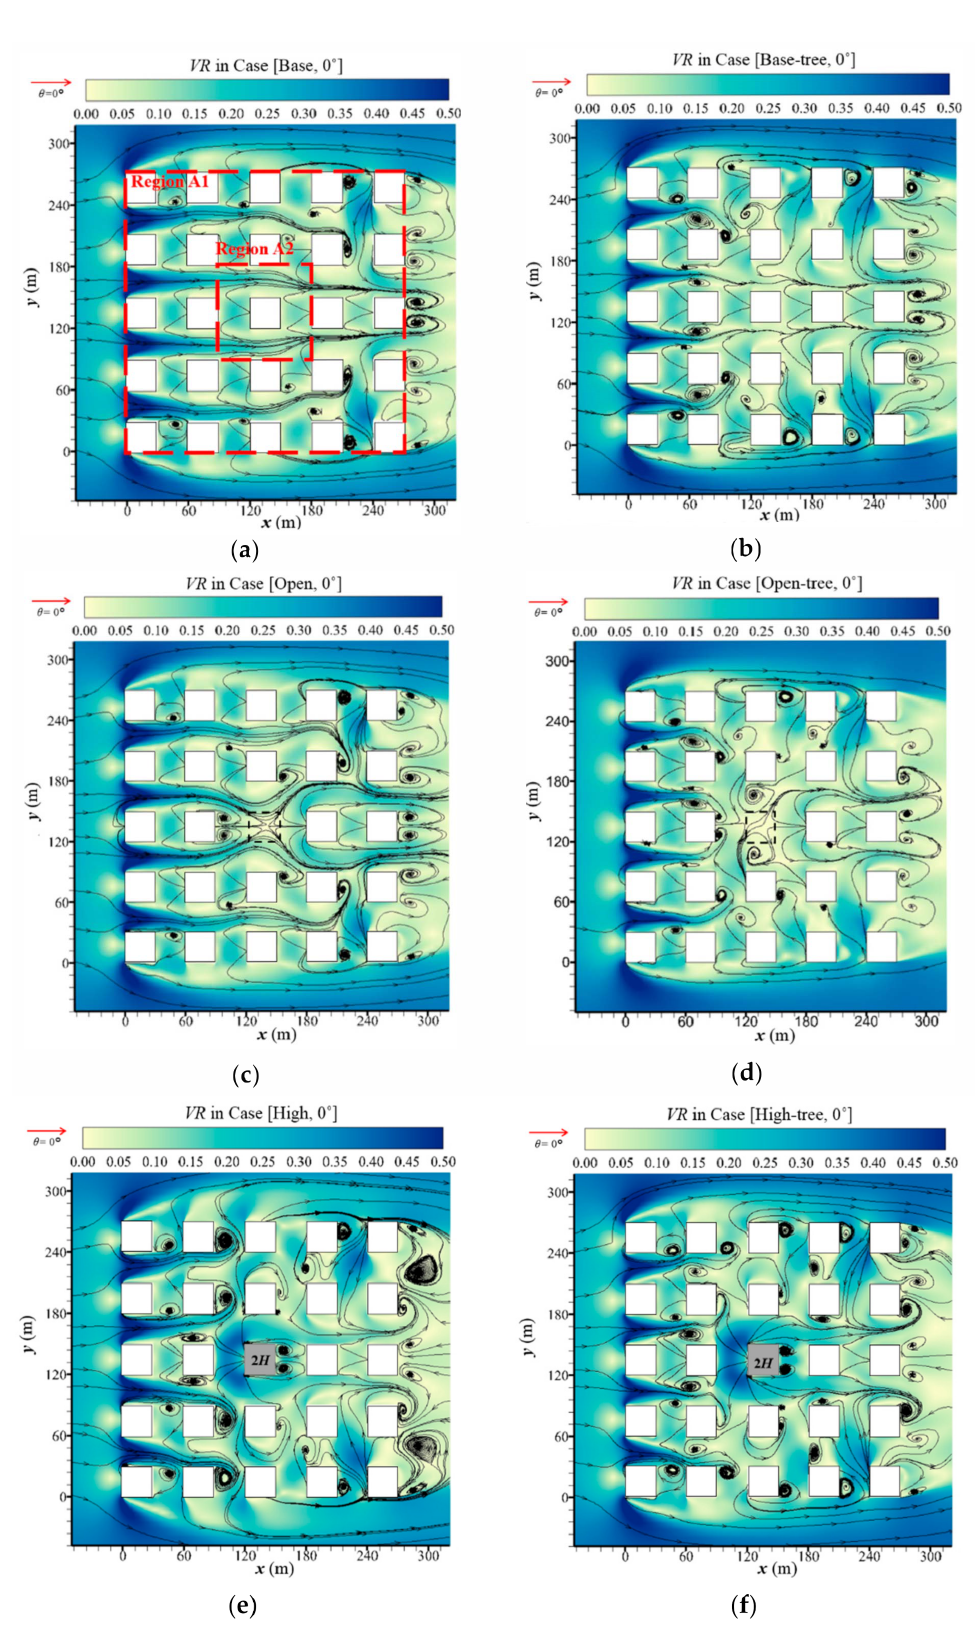
Figure 2. Streamline and velocity ratio ( VR ) at z = 2m in ( a ) Case [Base, 0 ◦ ], ( b ) Case [Base-tree, 0 ◦ ], ( c ) Case [Open, 0 ◦ ], ( d ) Case [Open-tree, 0 ◦ ], ( e ) Case [High, 0 ◦ ] and ( f ) Case [High-tree, 0 ◦